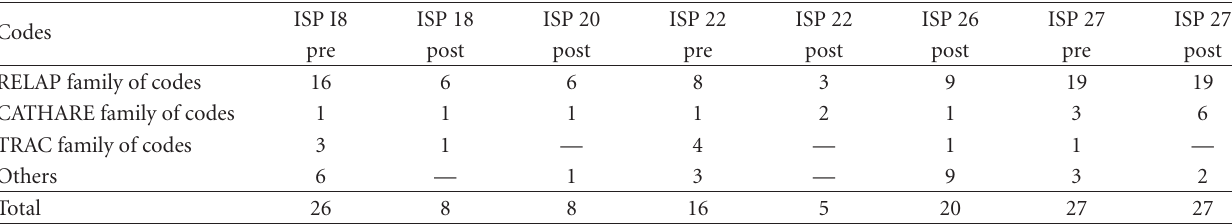
Table 8: Calculations per code groups per